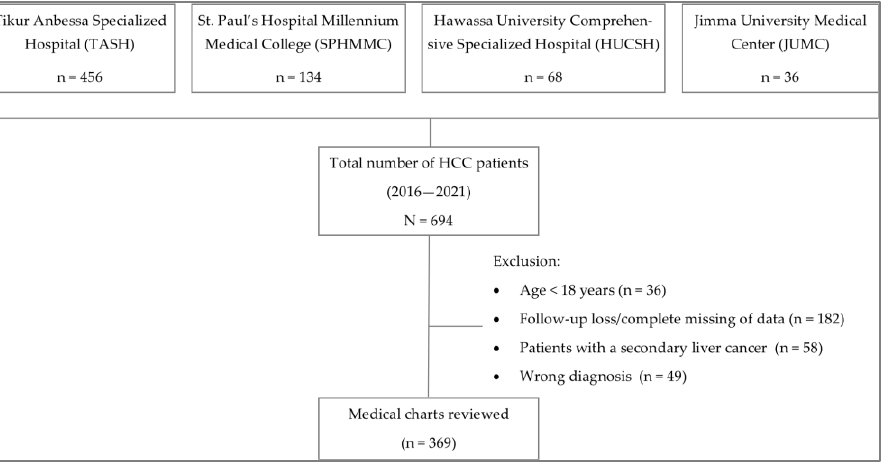
Figure 1. Flow chart showing the number of HCC patients enrolled in the